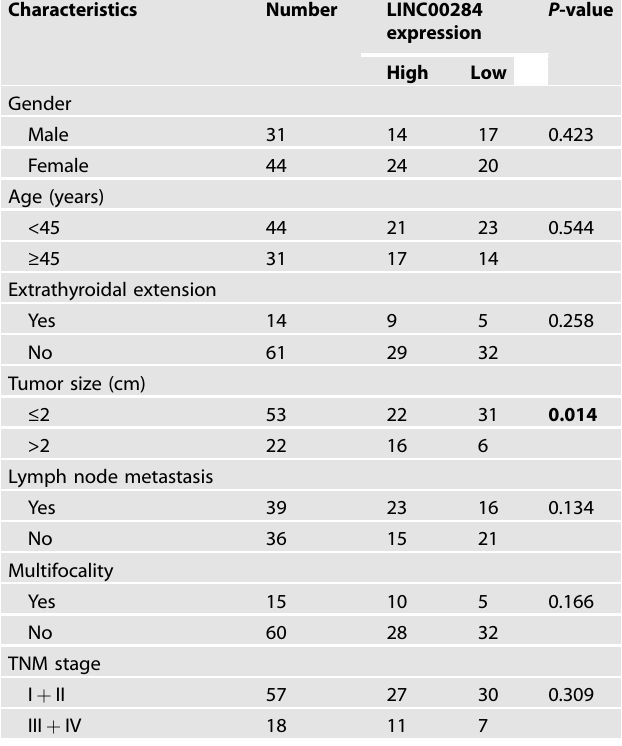
Table 1. Correlation between LINC00284 expression and clinicopathological features in papillary thyroid cancer.